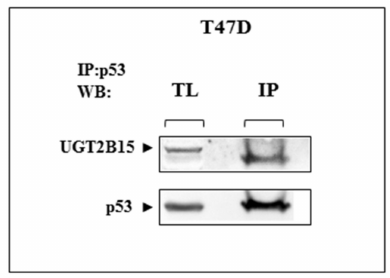
Figure 8. Physical interactions between UGT2B15 and p53. T47D cells were lysed and immunopre- cipitated with anti-p53. Precipitates were electrophoresed through 10% SDS-PAGE, blotted onto nitrocellulose filters, and immunoblotted with anti-UGT2B15 or anti-p53. IP, immunoprecipitation; WB, Western blotting; TL, total lysate. Results of a typical experiment repeated twice with similar results are shown.